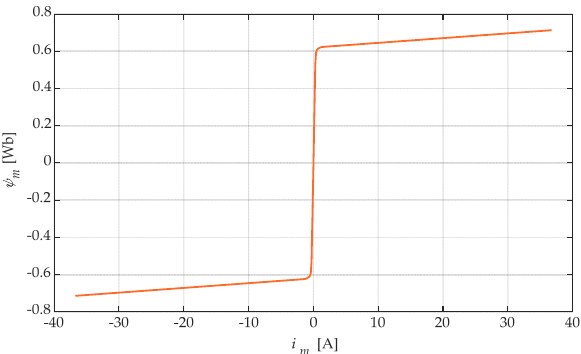
Figure 4. Voltage transformer magnetizing current vs linkage flux characteristic of the inductance L m .